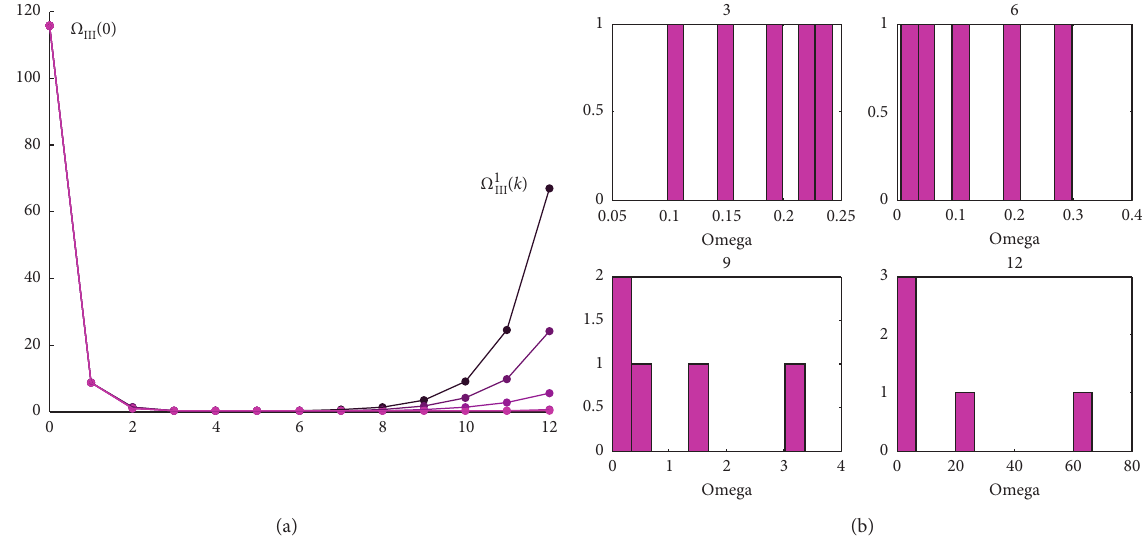
Figure 2: Simulation of five scenarios of violence Ω ( 0 ) � 115 . 5: (a) Ω n ( k ) for twelve months k � 12; (b) distribution of probable values of Ω n Ω III